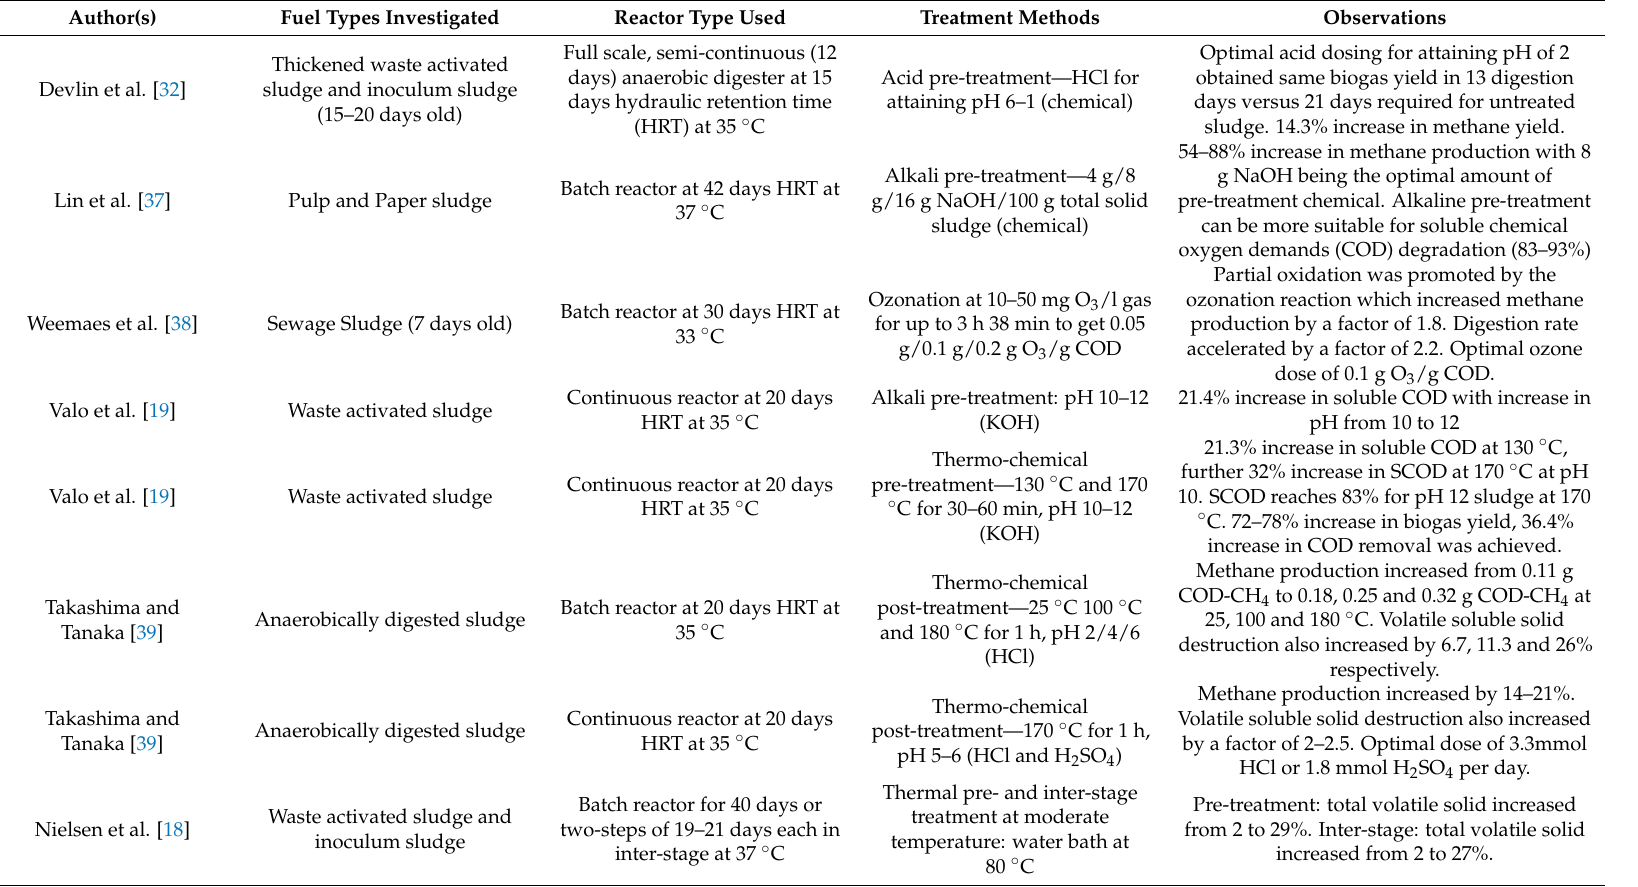
Table 1. Summary of key research on anaerobic digestion and pre-treatment